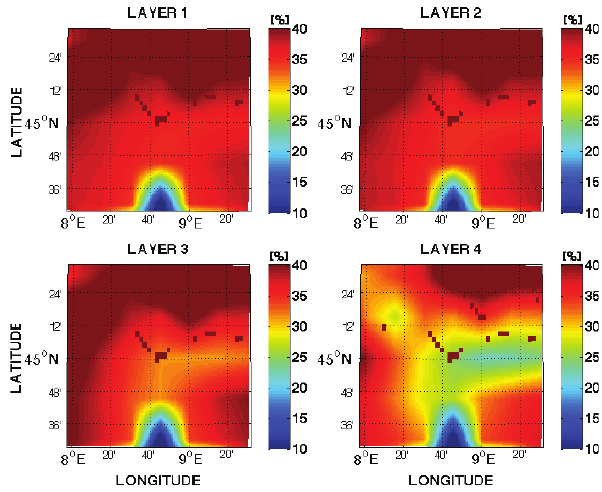
Fig. 5. Volumetric SMC (%) from ECMWF analysis at the four soil layers, on 25 April 2009,